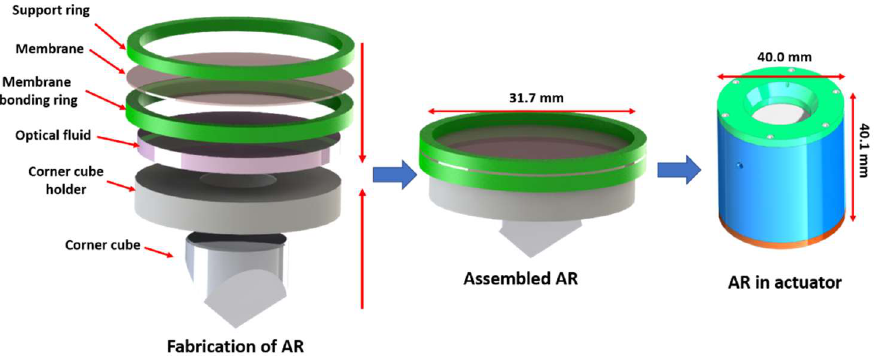
Figure 4. Schematic representation of the fabrication and assembly process of the